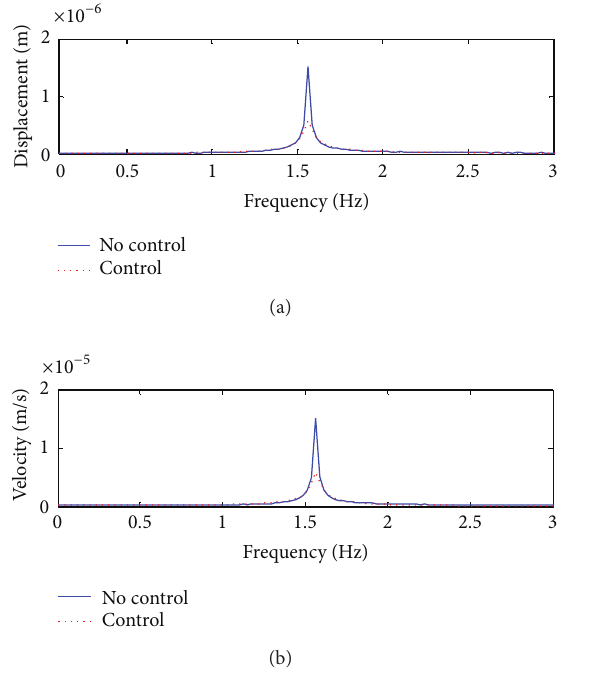
Figure 11: Spectrum analysis of control results in